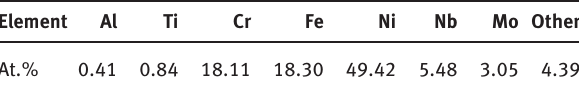
Table 1: The chemical composition of Inconel 718 alloys fabricated by selective laser melting. Element Al Ti Cr Fe Ni Nb Mo Other At.%